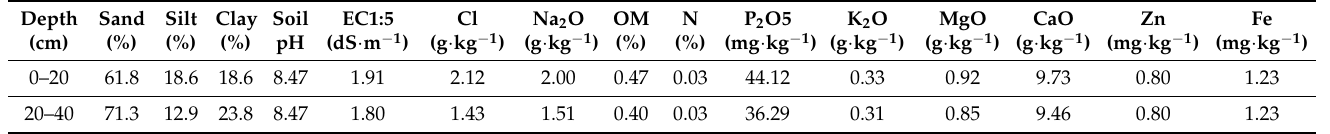
Table 3. Initial soil physical and chemical properties in the experimental site.